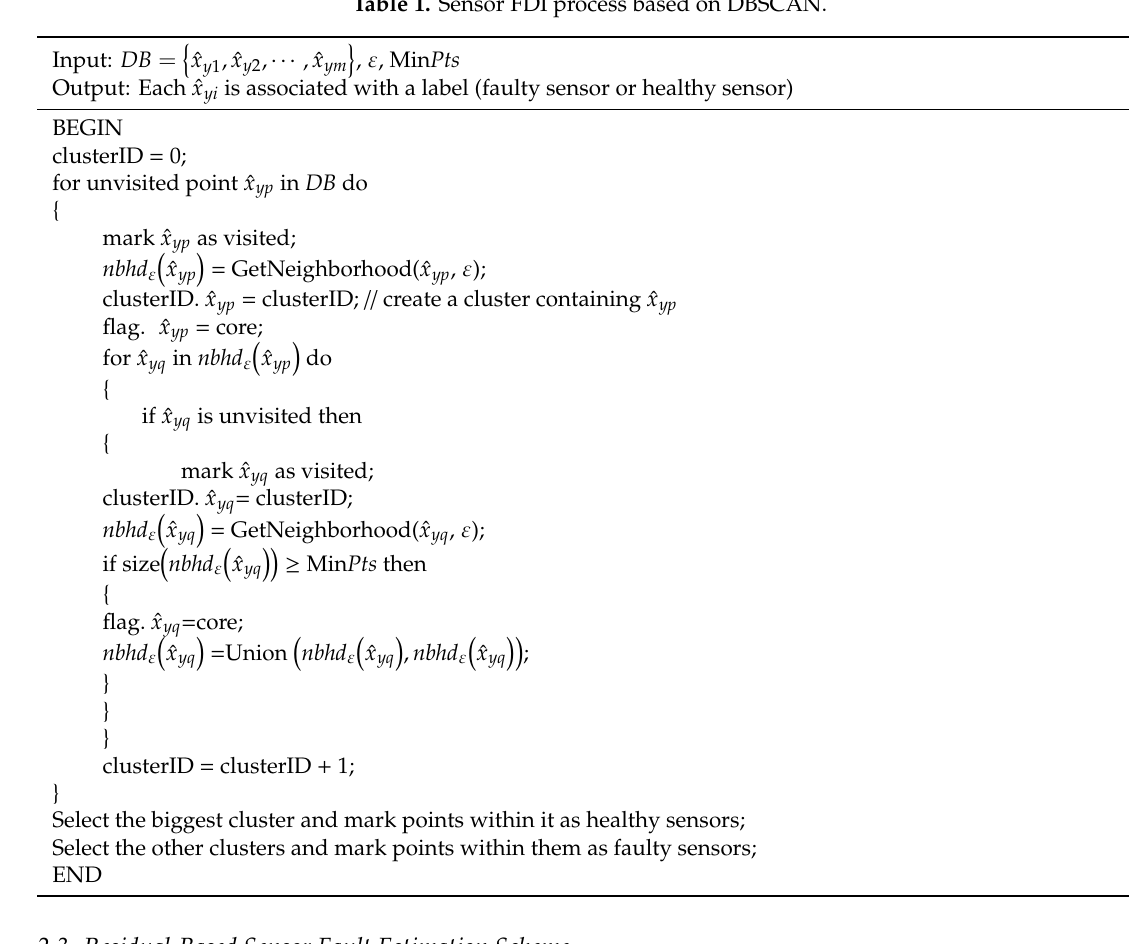
Table 1. Sensor FDI process based on